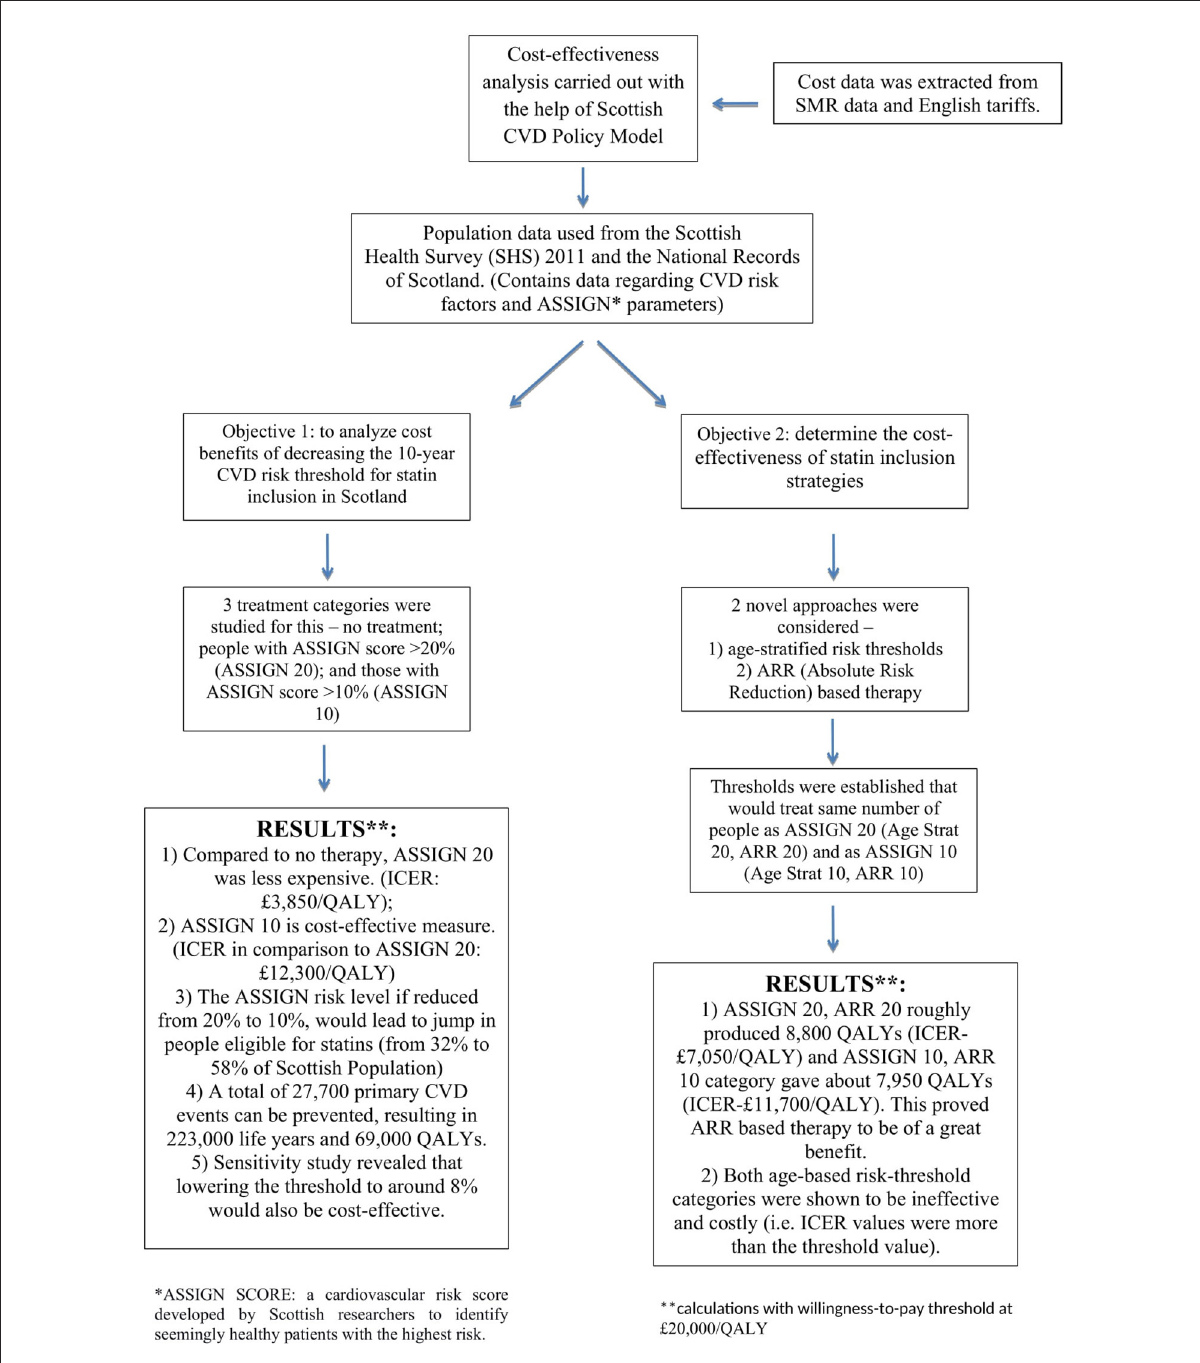
FIGURE1 Study design and